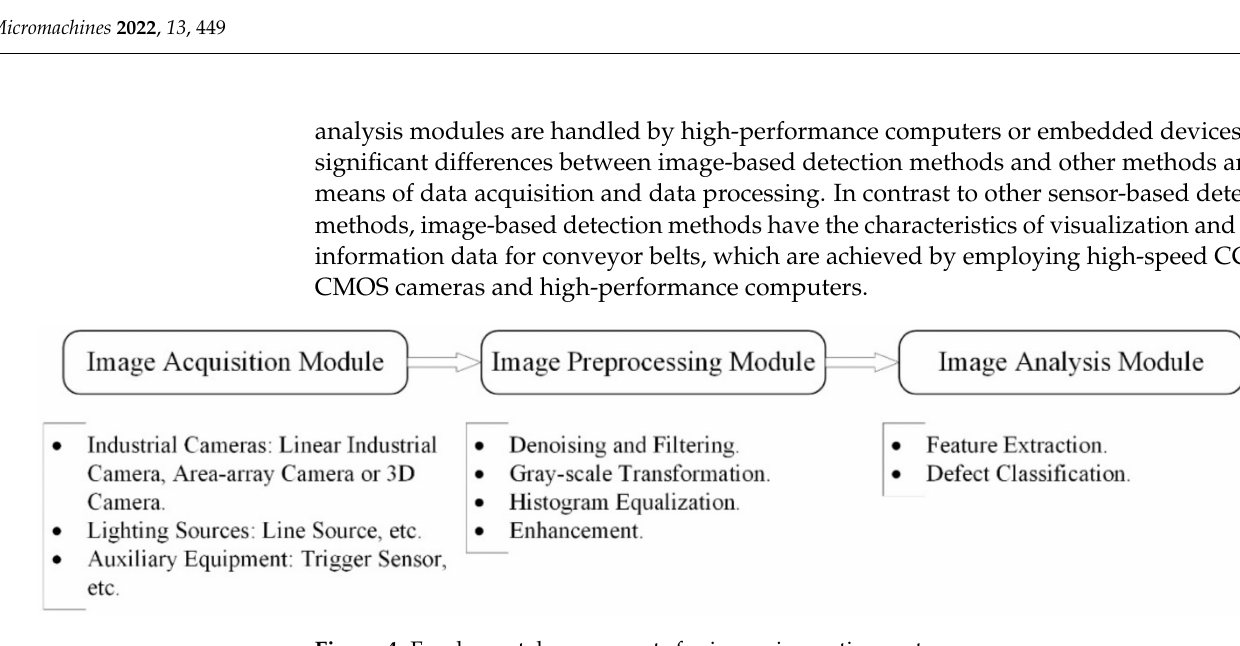
Figure 4. Fundamental components for image inspection system.